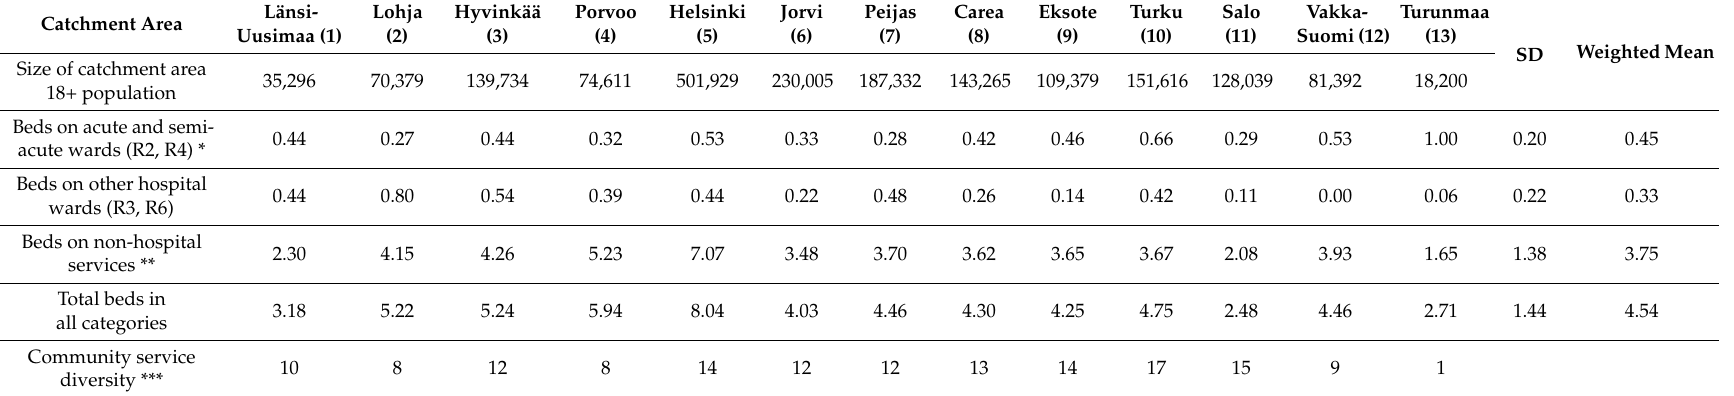
Table 1. Provised beds on different types of psychiatric wards and non-hospital services per 1000 (18+) and community service diversity. Catchment